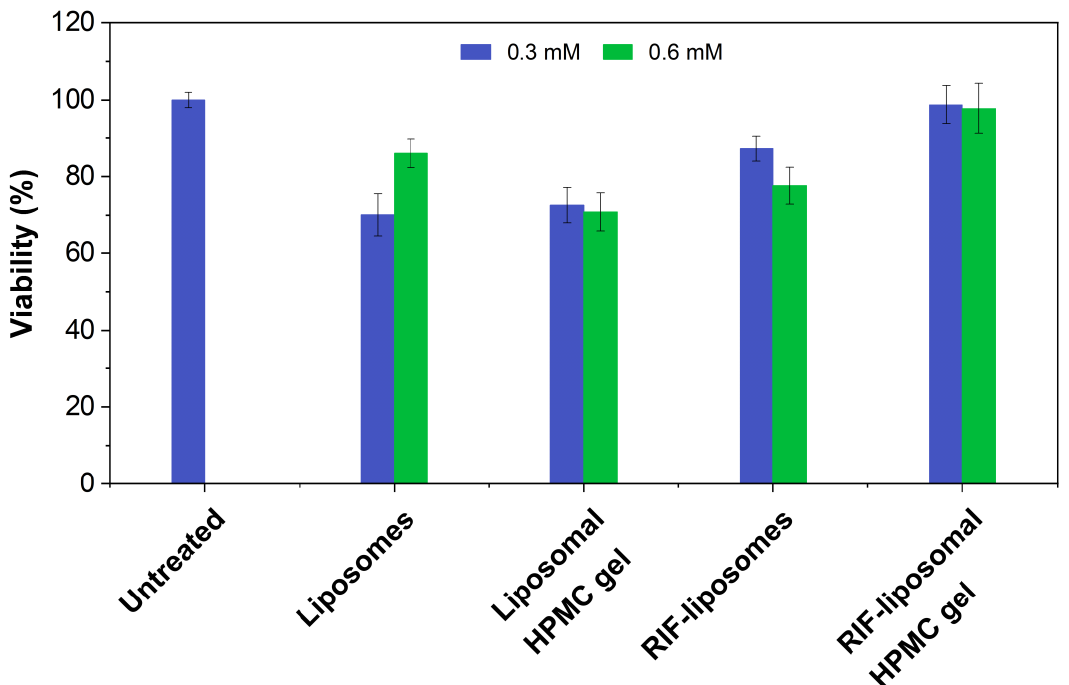
Figure 9. Investigation of the in vitro skin irritation of the rifampicin-loaded liposomes and the nanostructured HPMC gel with rifampicin in comparison to a rifampicin solution. As a control, the vehicles without rifampicin were also examined.